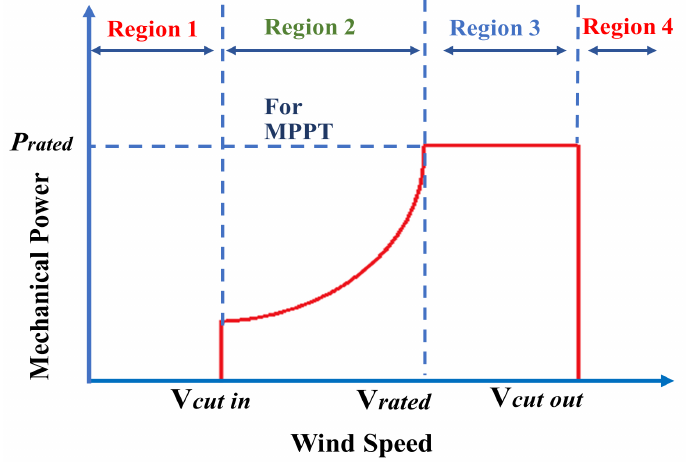
Figure 3. WECS operating regions. This figure is adapted with permission from Ref. [48]. Copyright 2021, Elsevier.